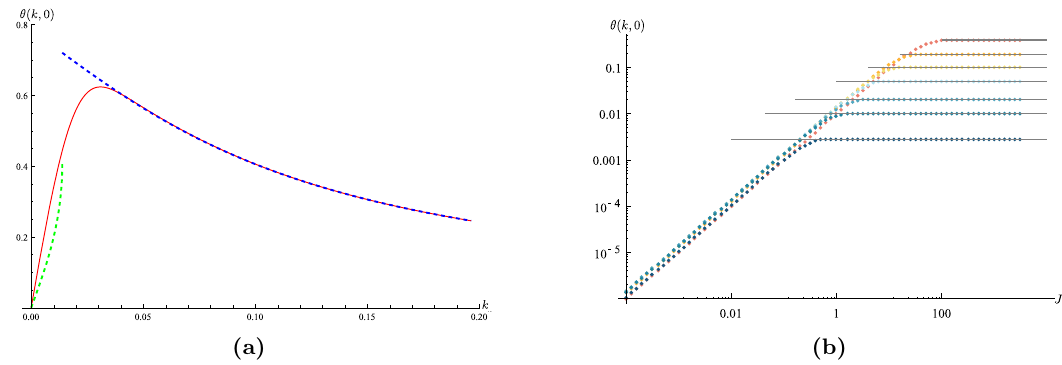
Figure 3. 3a: relation between single-mode contribution j (cid:18) j ( k; 0) and momentum k : red line shows the exact mode contribution to complexity (cid:18) ( k; 0); green and blue dashed lines are approximated complexity with KZ mass and critical mass, respectively. b = 0 : 1. 3b: relation between j (cid:18) j ( k; 0) and J(cid:14)t : from dark blue to red, k = 1 : 5 ; 0 : 5 ; 0 : 25 ; 0 : 1 ; 0 : 05 ; 0 : 025 ; 0 : 01; the grey solid horizontal lines